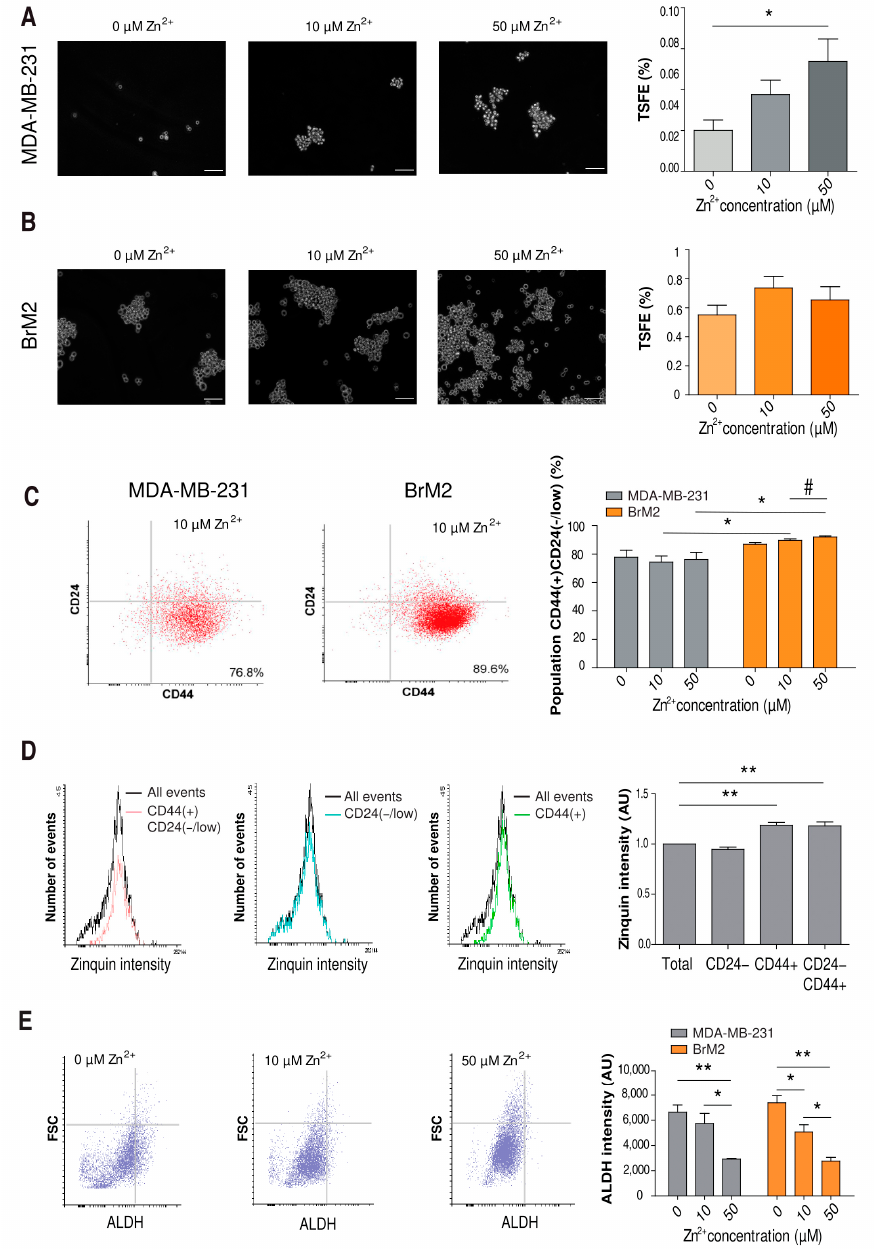
Figure 5. Characterization of tumorspheres in different zinc concentrations. ( A , B ) Left, representative pictures of MDA- MB-231 ( A ) and BrM2 ( B ) tumorspheres formed at 0, 10, and 50 µ M of ZnSO 4 after 21 days of differentiation. Scale bar = 100 µ m. Right, bar graph showing mean of TSFE for each condition. MDA-MB-231 cells ( n = 24) * p < 0.05 using Dunn’s multiple comparison test. BrM2 cells ( n = 22–27). ( C ) Representative flow cytometry dot blots of MDA-MB-231 and BrM2 tumorspheres stained with CD24-PE and CD44-APC. Right, percentage of CD44(+)CD24( − /low) cells after generating tumorspheres ( n = 4–6) * p < 0.05 using t -test, # p < 0.05 using ANOVA and Tukey’s multiple comparison test. ( D ) Evaluation of zinc content with Zinquin by flow cytometry in MDA-MB-231 cells showing total events and (left to right) CD44(+)CD24( − /low), CD24( − /low), and CD44(+) populations. Representative histograms: right, analysis of these populations normalized by the Zinquin intensity of the total cell population from each experiment ( n = 3) ** p < 0.01 using Dunnett’s multiple comparison. ( E ) Representative flow cytometry dot blots evaluating ALDH expression in MDA-MB-231 at 0, 10, and 50 µ M of ZnSO 4 (left). Analysis of ALDH expression in MDA-MB-231 and BrM2 at 0, 10, and 50 µ M of ZnSO 4 ( n = 3) * p < 0.05, ** p < 0.01 using ANOVA and Tukey’s multiple comparison